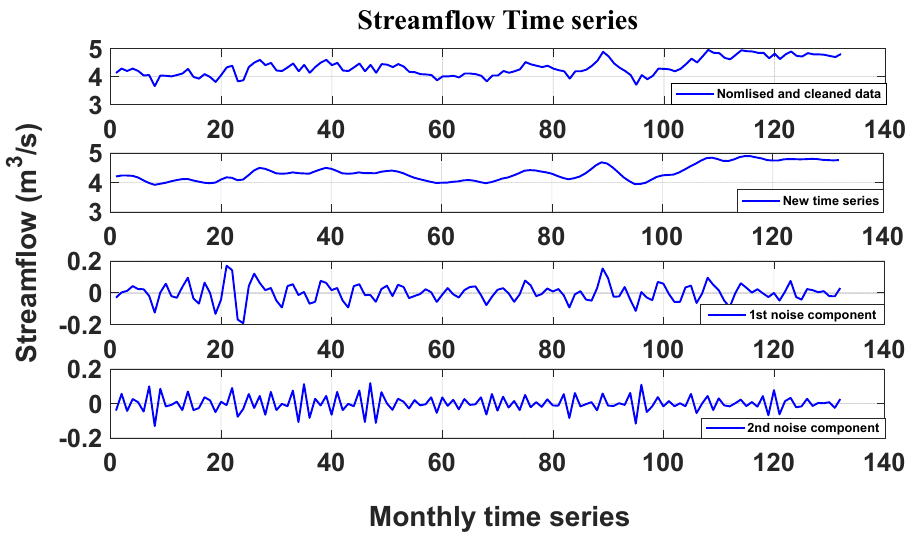
Figure 4. Normalized and cleaned streamflow time series and the three components obtained by SSA.